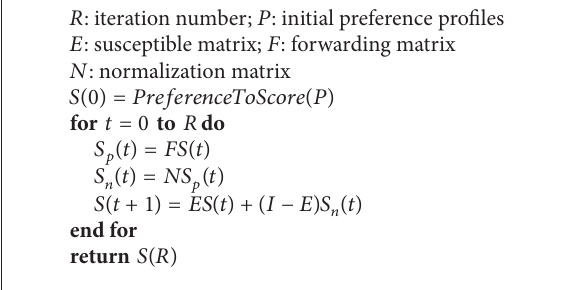
Algorithm 1: Preference propagation